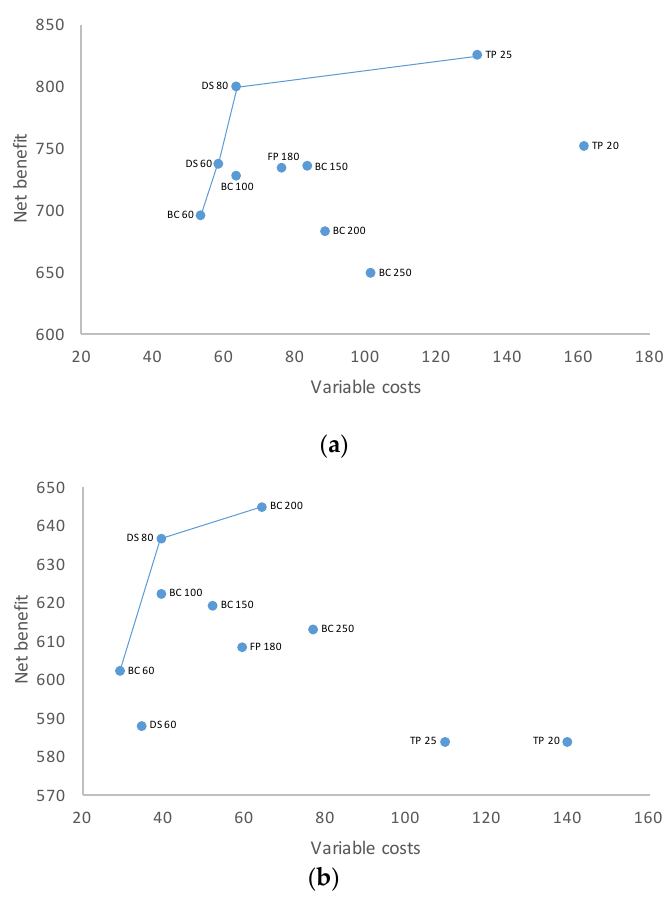
Figure 3. ( a ) Net benefit curve for rice seeding rates and methods without weed competition (USD). ( b ) Net benefit curves for rice seeding rates and methods with weed competition (USD).